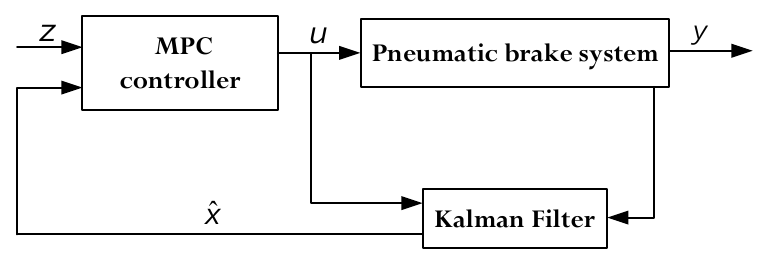
Figure 5. The principle of MPC applied to the